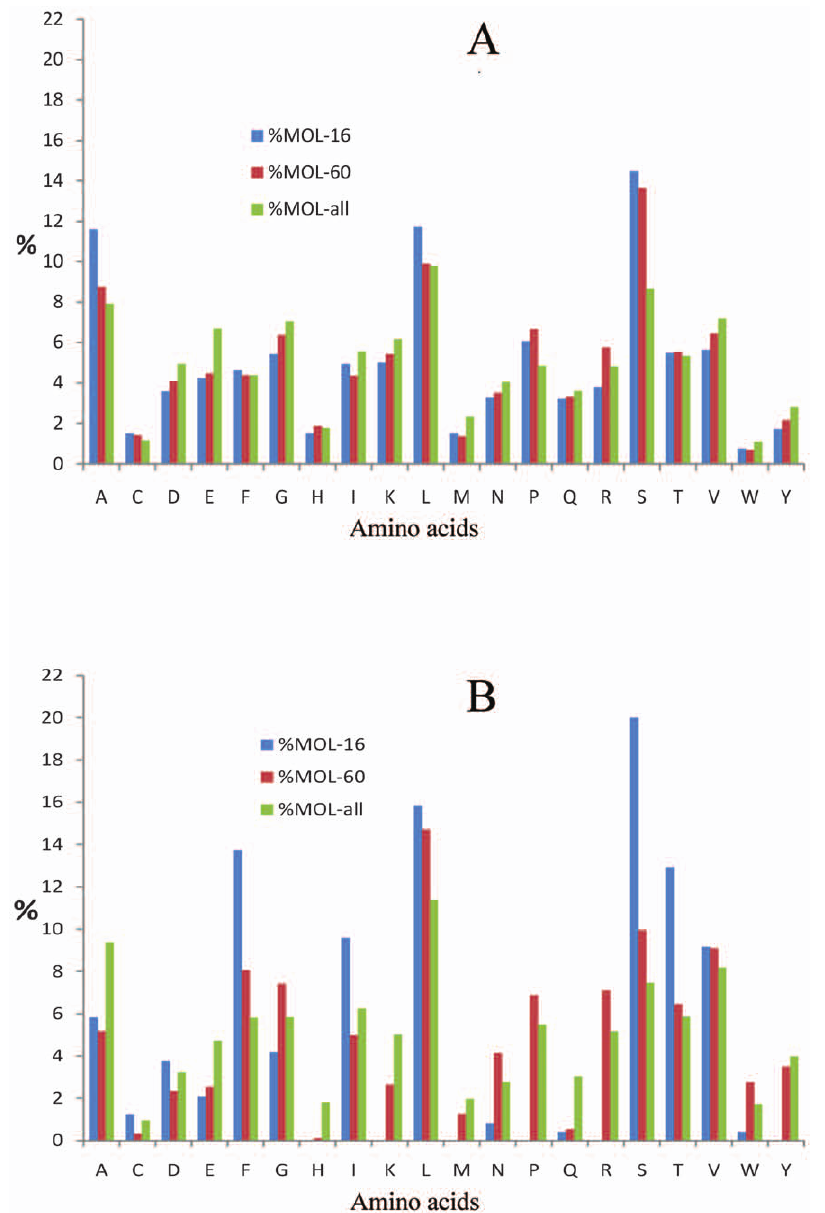
Figure 3. Amino acid composition of presequences. Analysis of the amino acid composition of the N-terminal sixteen residues (%MOL-16), N- terminal sixty residues (%MOL-60) and full-length proteins (%MOL-all) (A) analysis of the 123 chloroplast envelope proteins of A. thaliana (B) analysis of plant ERD4 orthologs.